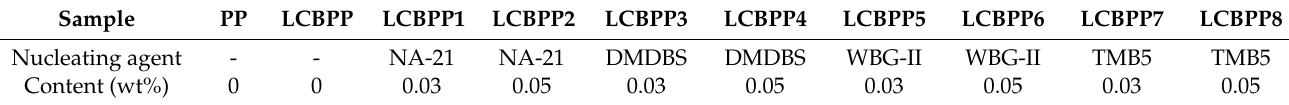
Table 1. Test samples with different nucleating